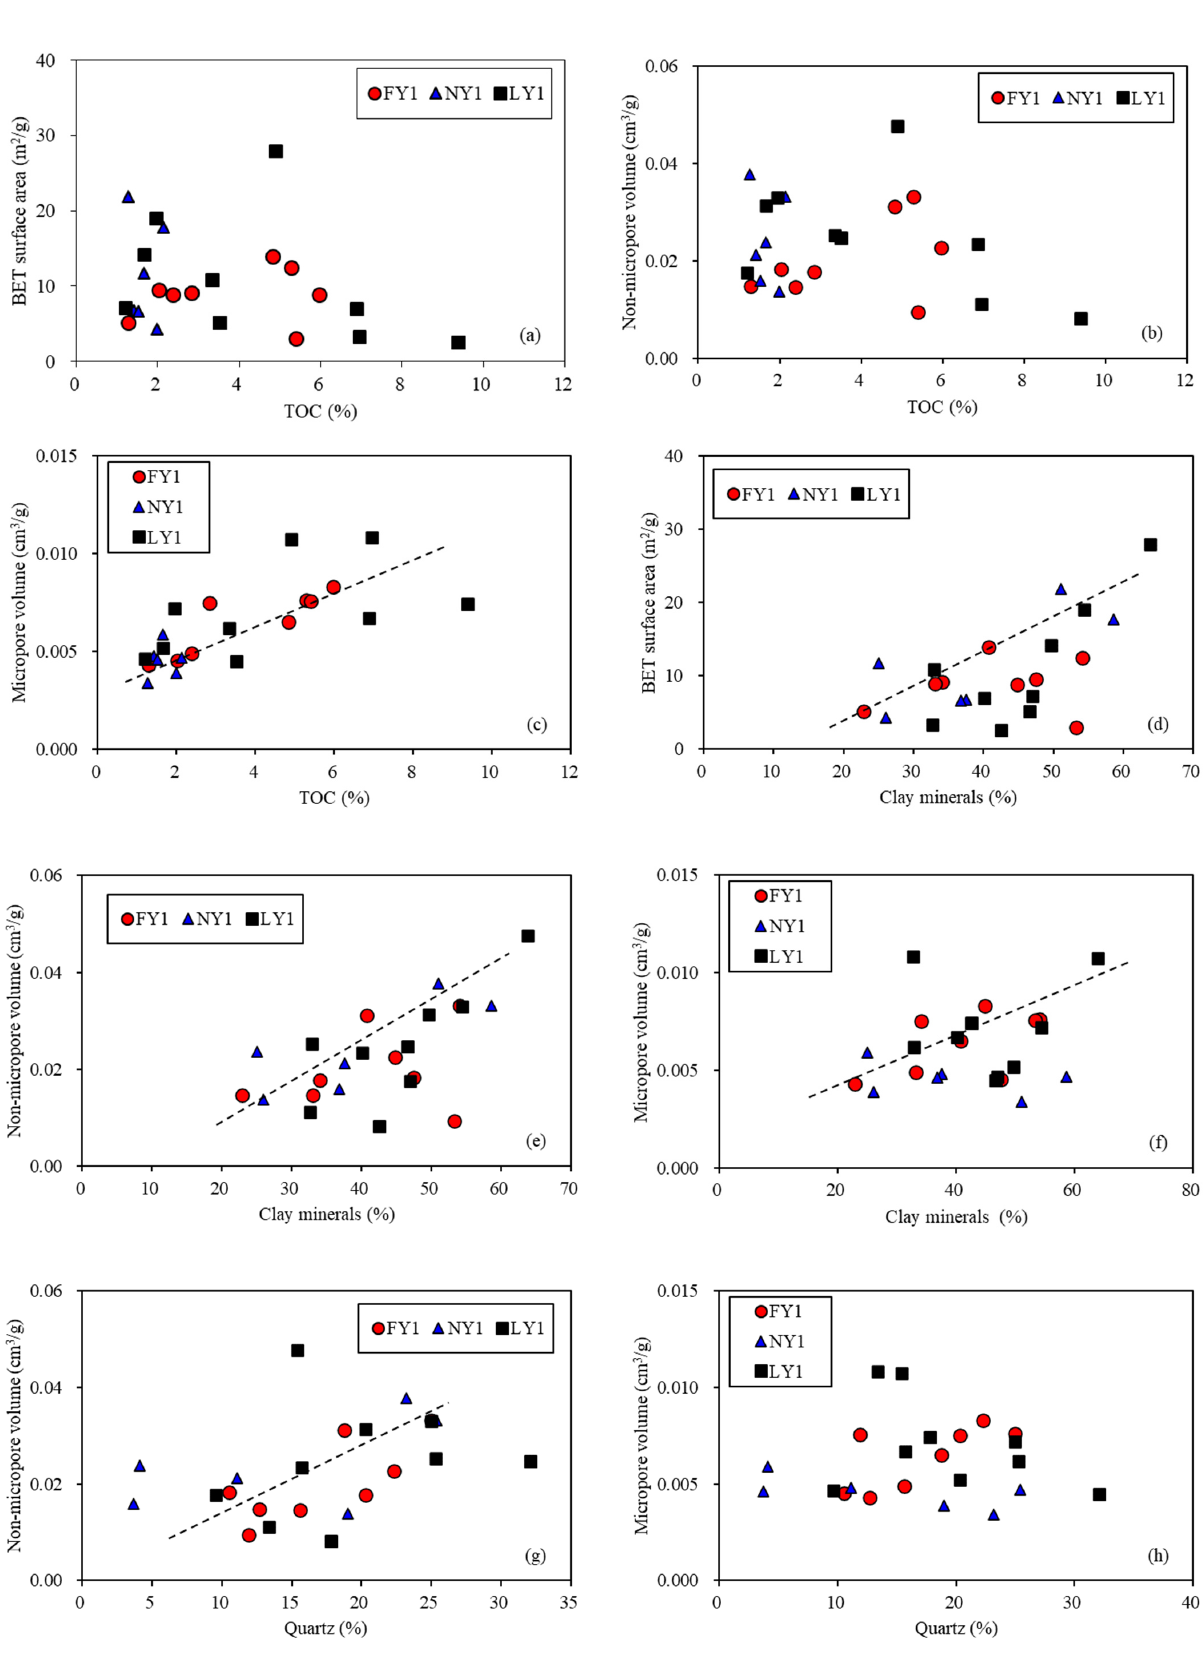
Figure 12. Plots showing relationships of porosity with TOC ( a ) and different minerals ( b – d ) for the studied samples.